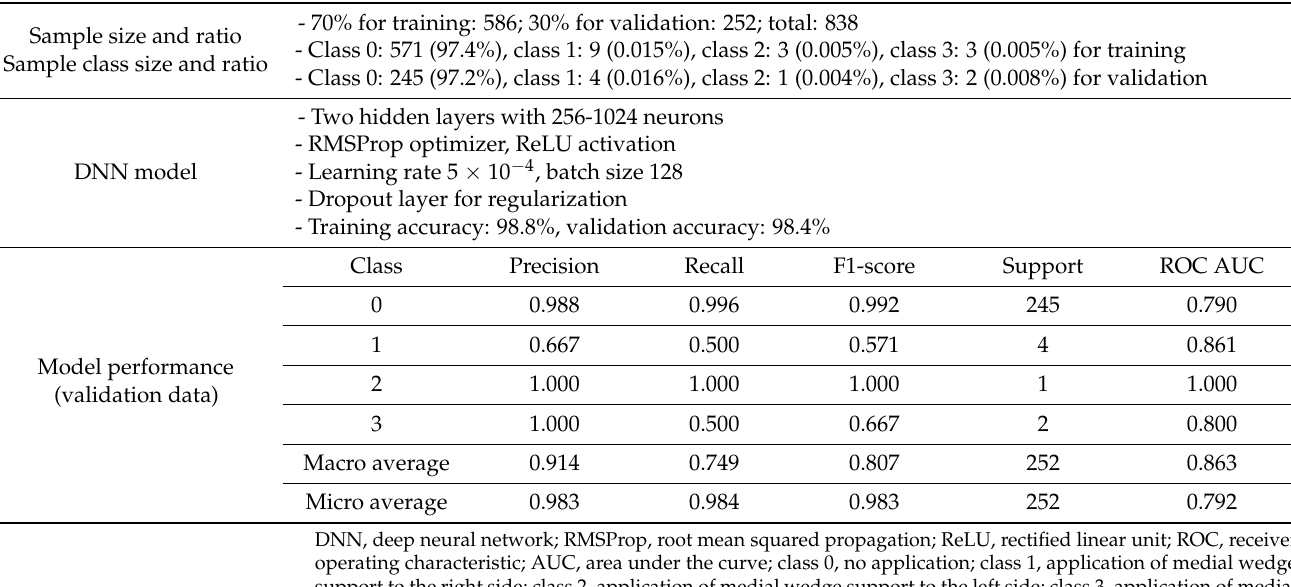
Table 4. Details of the model for determining the application of lateral wedge support.